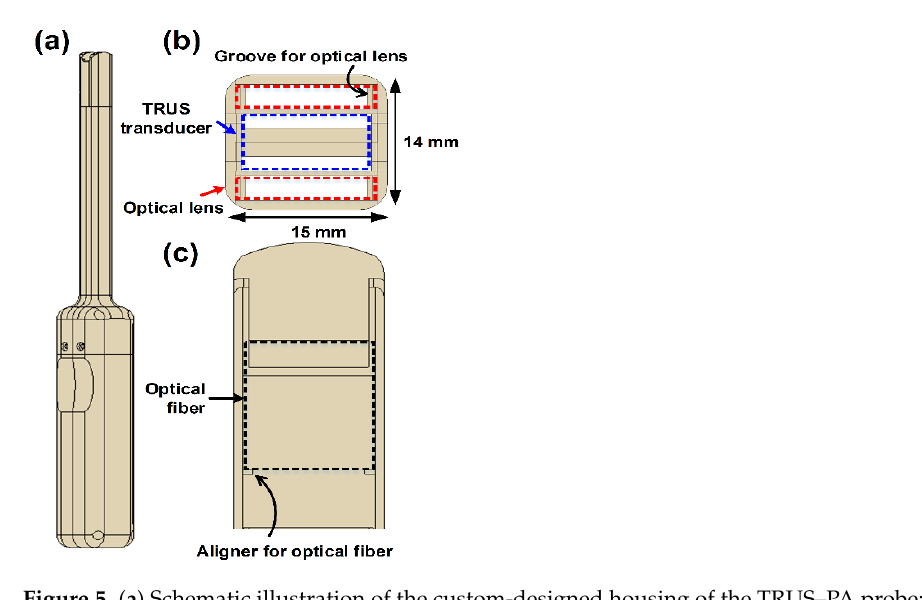
Figure 5. ( a ) Schematic illustration of the custom-designed housing of the TRUS–PA probe: ( a ) side view and ( b ) front view of the housing, and ( c ) cross-section view of the housing tip.